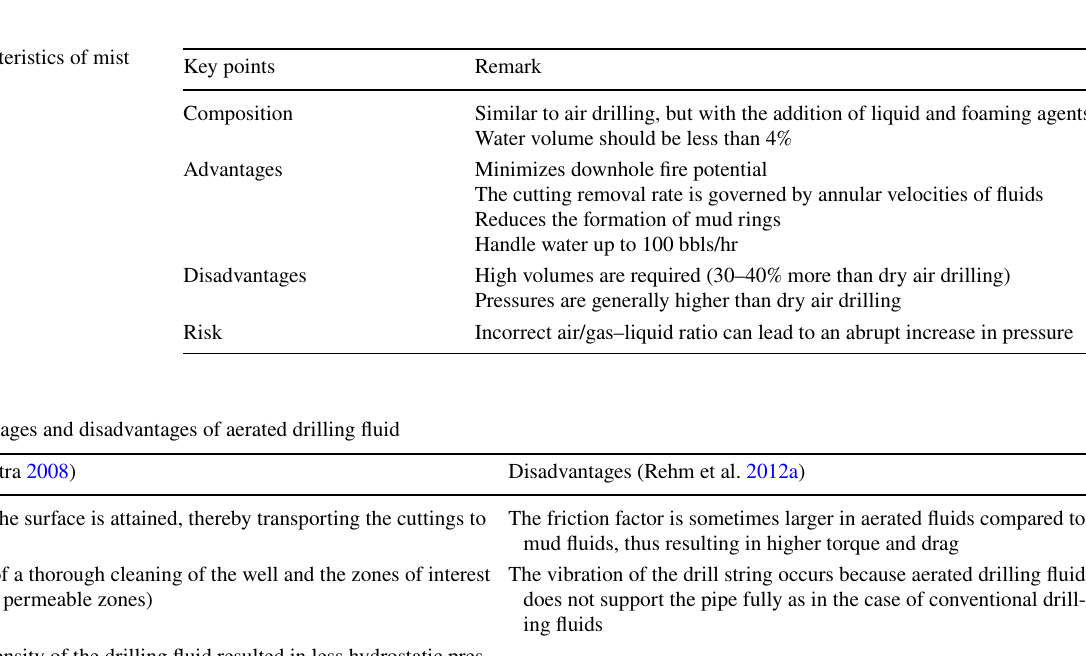
Table 3 Characteristics of mist drilling